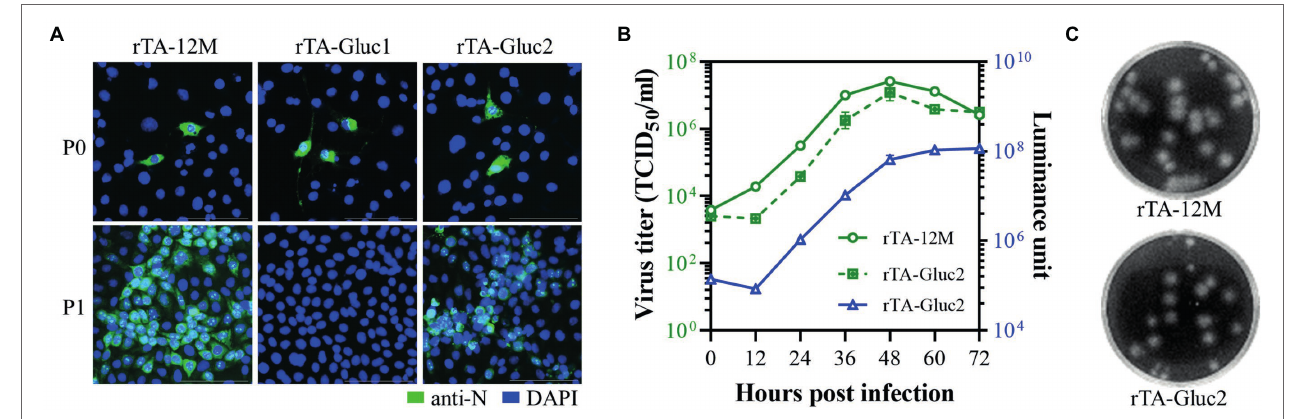
FIGURE 2 | Recovery and in vitro characterization of the recombinant viruses. (A) Recovery of the recombinant viruses. Briefly, BHK-21 cells in a 12-well plate were transfected with 2 μ g cDNA clone plasmid per well using Lipofectamine 3,000 transfection reagent according to the manufacturer’s instructions. At 48 hpt, culture supernatant was harvested as passage zero (P0) virus, while cells were fixed for the detection of N protein via IFA. The P0 virus was further passaged to MARC-145 cells. When typical CPE was observed, culture supernatant was harvested as P1 virus, and N protein expression in cells was confirmed by IFA. The nucleus was counterstained with DAPI. Pictures were taken under an epifluorescent microscope. (B) The multi-step virus growth curves. MARC-145 cells in a 24- well plate were infected with recombinant viruses of P3 at an MOI of 0.01, respectively. Virus supernatants harvested at 0, 12, 24, 36, 48, 60, and 72 hpi were titrated by TCID 50 assay (left Y axis) and luciferase assay (right Y axis). Each data point represents the mean ± deviation of duplicates. (C) Plaque morphology of the recombinant viruses. MARC-145 cells were infected with serial diluted recombinant viruses and covered with 1% low melting point agarose supplemented with 2% FBS. At 3 days post-infection, the plaques formed by virus infection were visualized by crystal violet